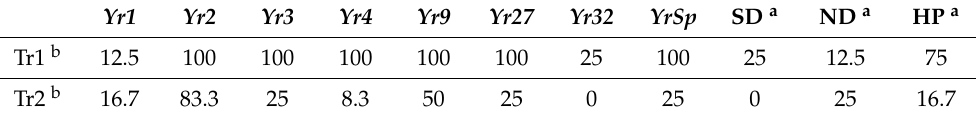
Table 4. Virulence frequencies in two groups of P. striiformis collections from triticale in Russia.